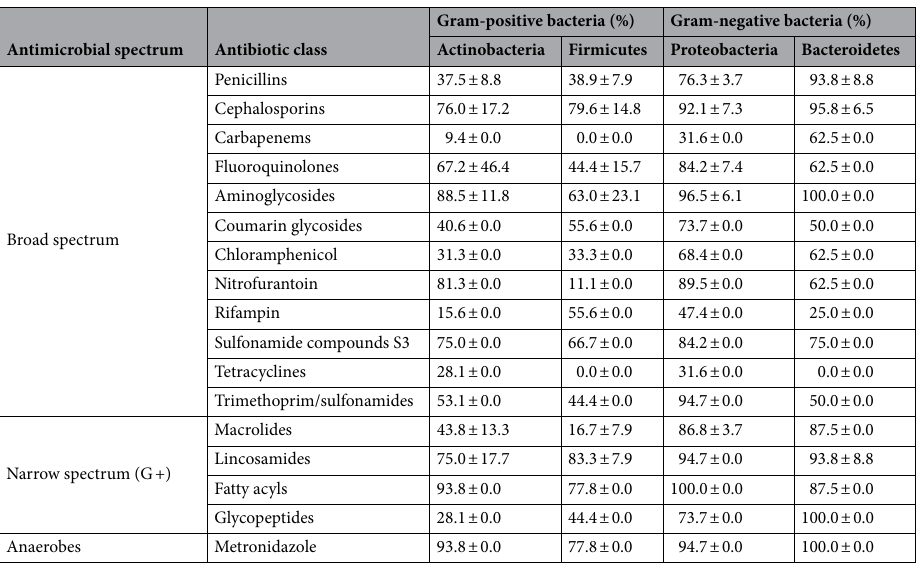
Table 1. Antimicrobial susceptibility of bacterial isolates from Scarisoara cave ice core. Percentage of resistant strains to the 17 tested antibiotic classes was indicated for different bacterial phyla and Gram-stain type (average and standard deviation